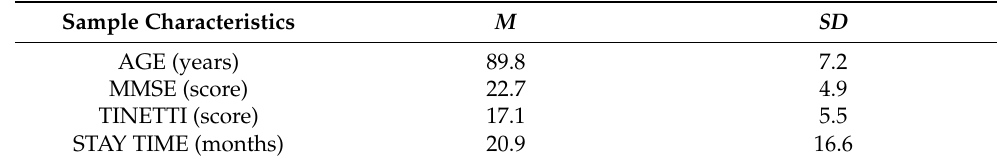
Table 1. Description of participant age, Mini-Mental State Examination (MMSE), and perception of balance and stability (TINETTI), shown as the mean (M) and standard deviation (SD). Sample